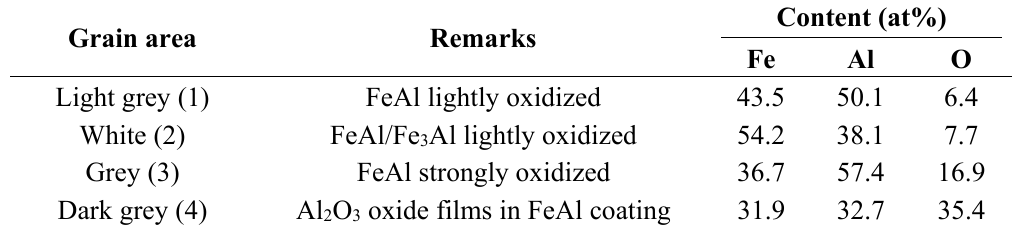
Figure 2. Morphology on the cross section of strongly deformed and oxidized, dispersive grains of the D-gun FeAl type coating, deposited in “high” value of the detonation energy. Table 1. Microanalysis of the chemical composition of D-gun sprayed Fe-Al type coating deposited in high spraying energy (grains area according Figure